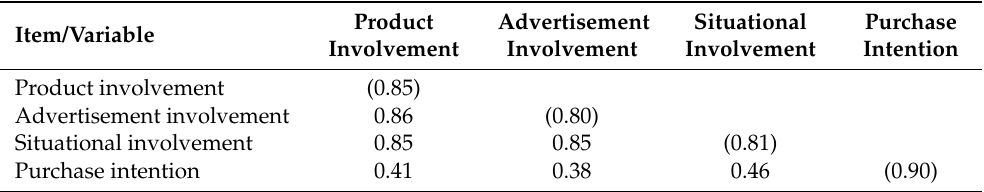
Table 3. Heterotrait–monotrait ratio of correlation ( n =